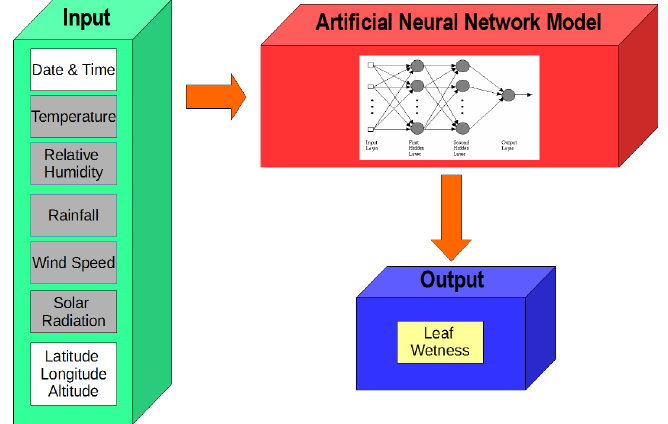
Figure 3. Proposed Artificial Neural Network (ANN) for leaf wetness